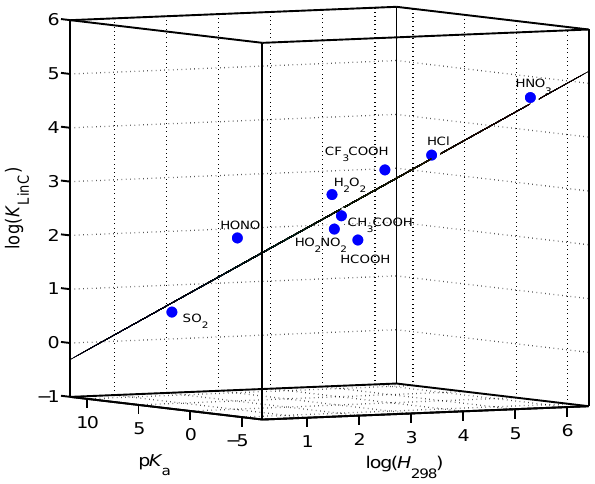
Fig. 5. Multiple linear regression with the input parameters acid dissociation constant (p K a ) and molecular Henry constant ( H 298 [Matm − 1 ]) versus the K LinC [cm − 1 ] on ice at 228K.